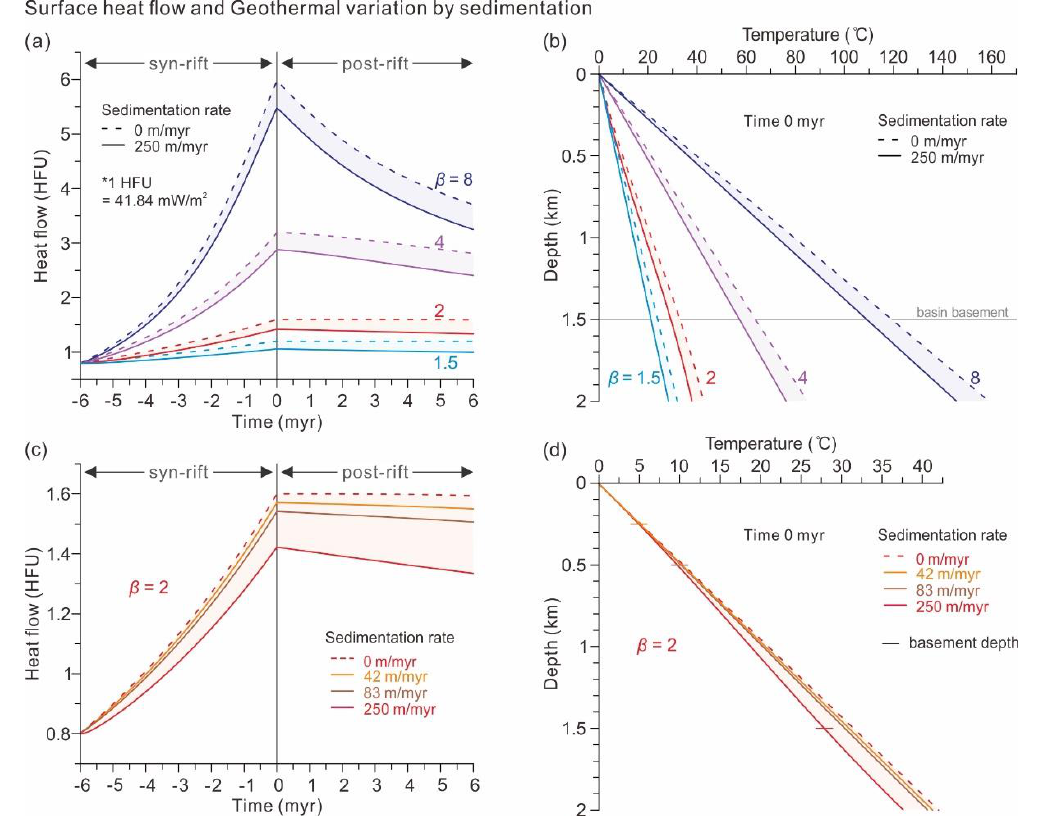
Figure 4. Surface heat flow and geothermal variation by sedimentation. Negative and positive values on the time axis indicate the syn-rift and post-rift phases, respectively; each phase duration is 6 myr in the model. The geothermal gradient model depicts the upper 2 km at time 0 myr (rifting cessation). Models of ( a ) surface heat flow and ( b ) geothermal gradient, applying β = 1.5, 2, 4 and 8. The dashed and solid lines are calculated with sedimentation rates of 0 and 250 m/myr, respectively. Models of ( c ) surface heat flow and ( d ) geothermal gradient of β = 2, applying sedimentation rates of 0, 42, 83 and 250 m/myr (total stacked sediment layers of 0, 500, 1000 and 3000 m in thickness, respectively). During the syn-rift phase, the surface heat flow increased starting from 0.8 HFU at −6 myr. The higher β causes greater heat flow due to greater lithospheric thinning and rising of the asthenosphere top (Figure 4a). Due to heat loss during the syn-rift, however, the values in the models for sedimentation rate, 0 m/myr, were lower than those for the simultaneous rifting model, as shown